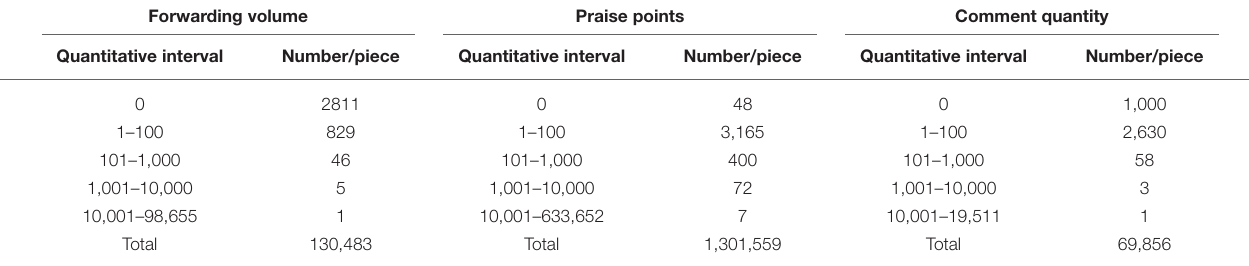
TABLE 3 | Statistics of forwarding, likes and comments of short fitness videos on TikTok. Forwarding volume Praise points Comment quantity Quantitative interval Number/piece Quantitative interval Number/piece Quantitative interval